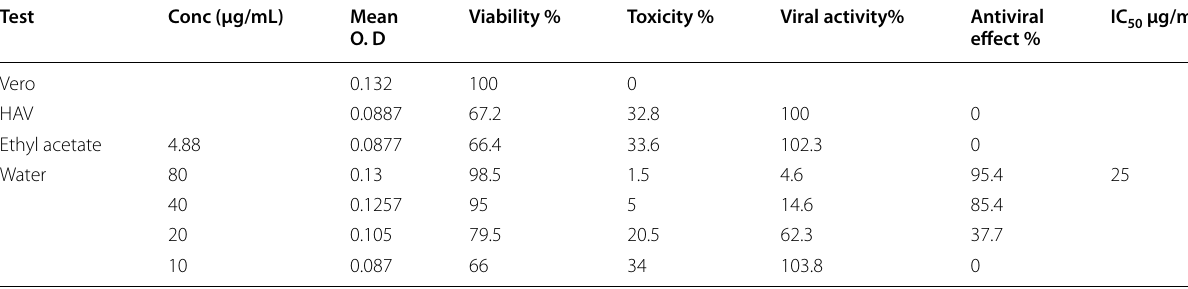
Table 6 Detection of antiviral activity for MNTC of mushroom extracts